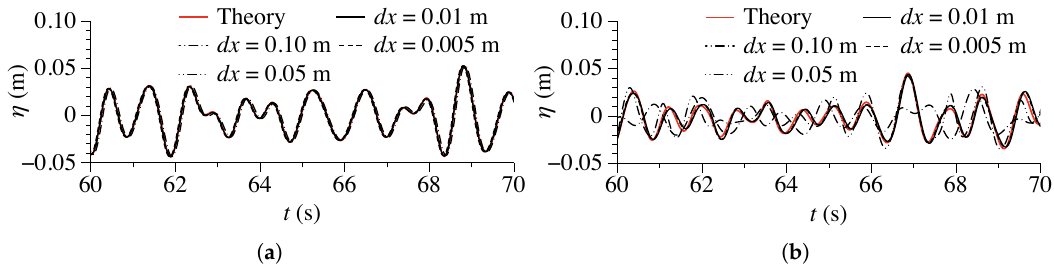
Figure 3. Comparison of the theoretical input and reconstructed irregular wave signal for case B ( a ) W1 ( x = 0 m); ( b ) W2 ( x = 11